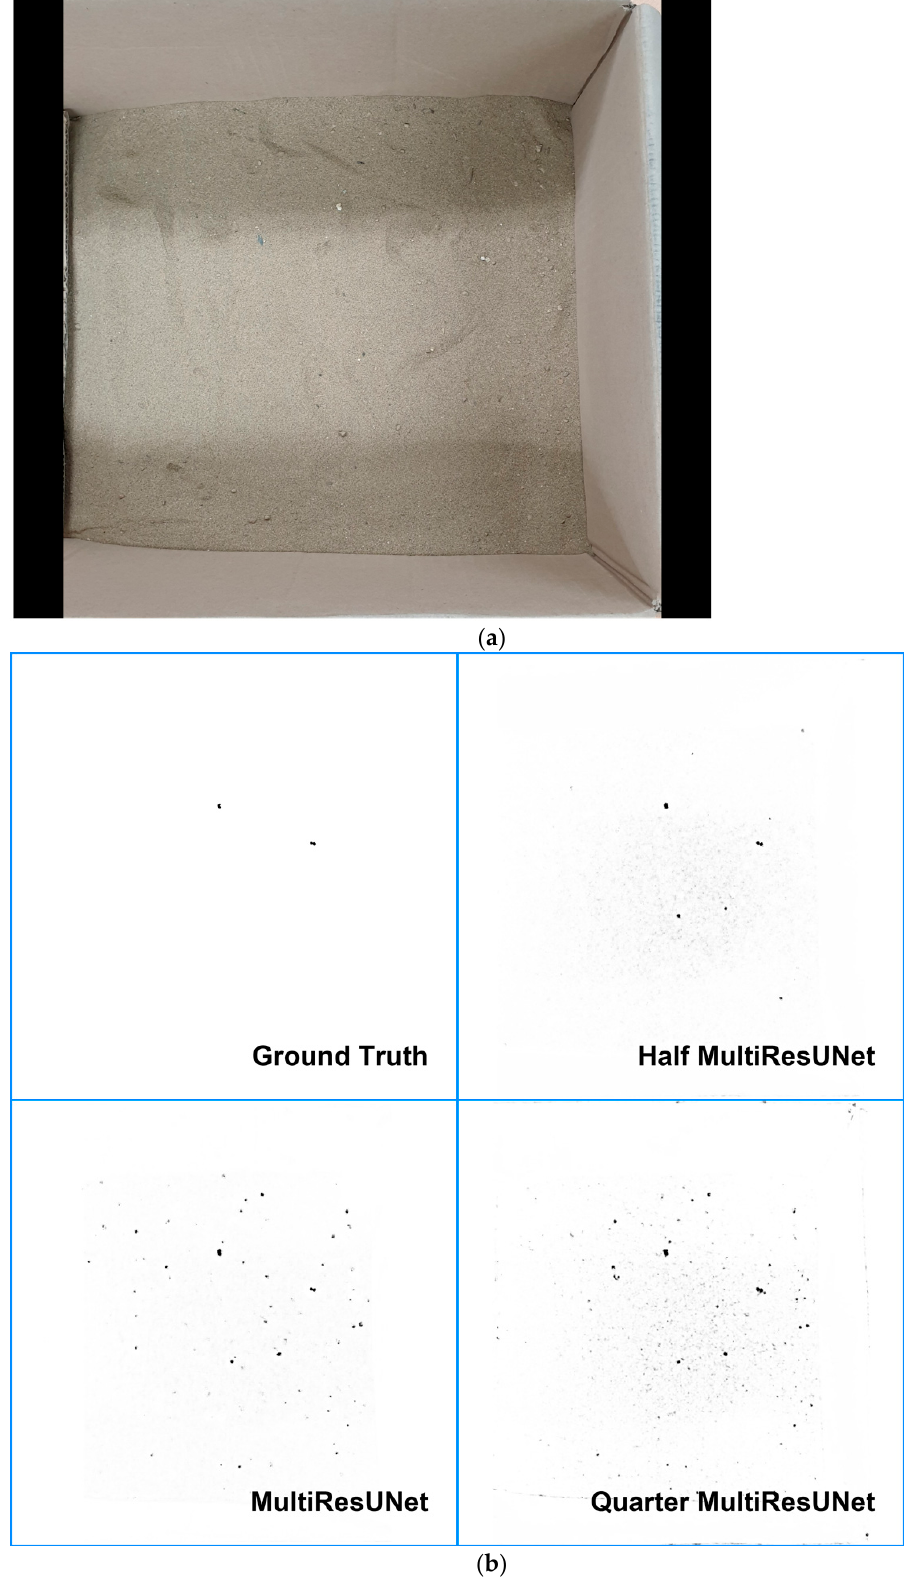
Figure 10. Prediction result images by 3 models with source image ( a ) and ground truth image. ( a ) Source Image from one of test dataset. ( b ) Ground truth and outputs of 3 models from one of test dataset.